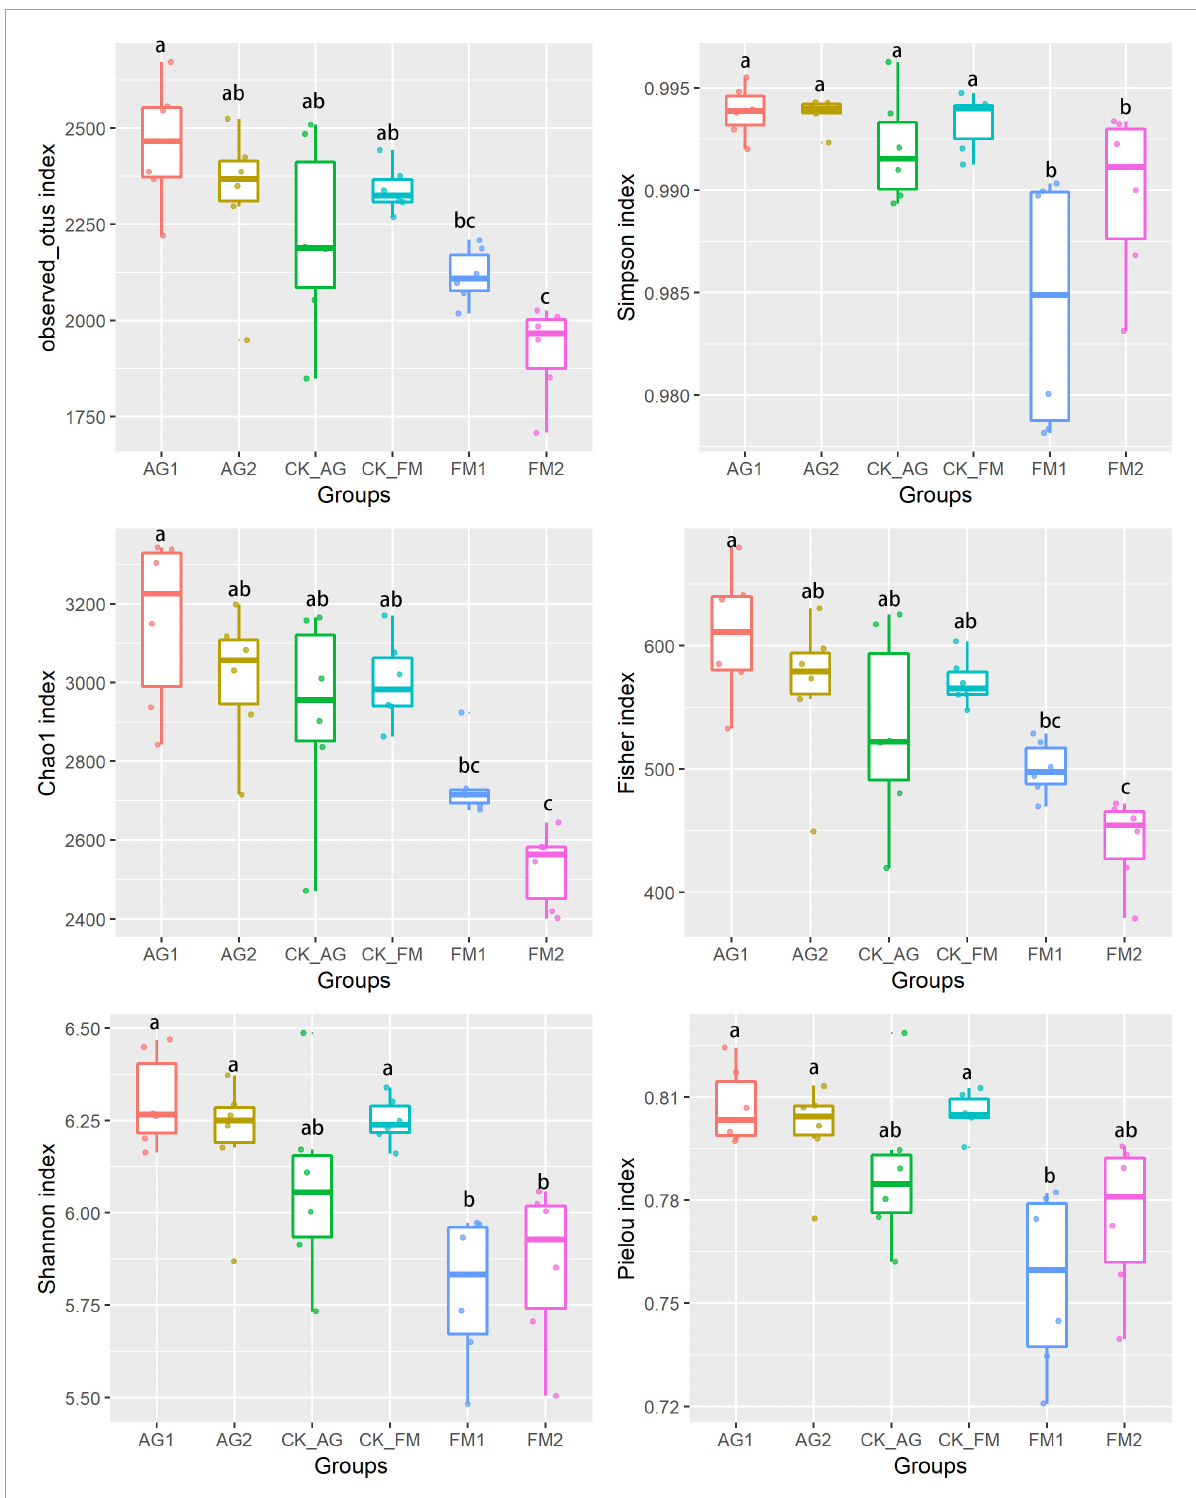
FIGURE2 Bacterial diversity index in soil with different treatments. AG1, microbial agent 1 treatment; AG2, microbial agent 2 treatment; CK_AG, untreated control in biological treatment experiment. FM1, CoCl 2 , cobalt dichloride fumigation treatment; FM2, dazomet fumigation treatment; CK_FM, untreated control in fumigation experiment. Different letters above the box indicated the differences between treatments were significant at p < 0.05